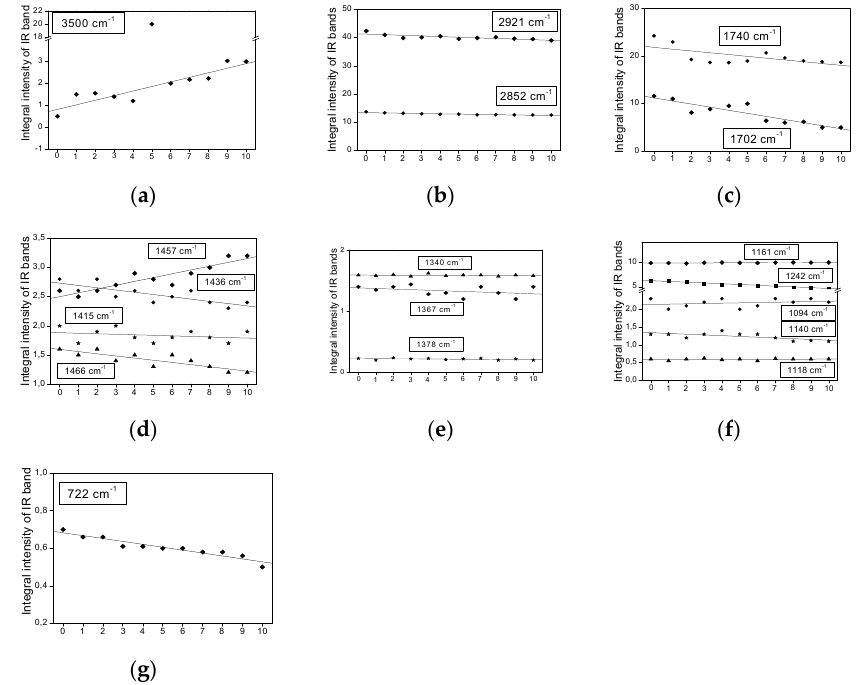
Figure 4. Heating-time dependence of the band intensity observed in the IR spectra of palm oil at: ( a ) 3500, ( b ) 2921 and 2852, ( c ) 1740 and 1702, ( d ) 1466, 1457, 1436 and 1415, ( e ) 1378, 1367 and 1340, ( f ) 1242, 1161, 1140, 1118 and 1094, and ( g ) 722 cm − 1 .